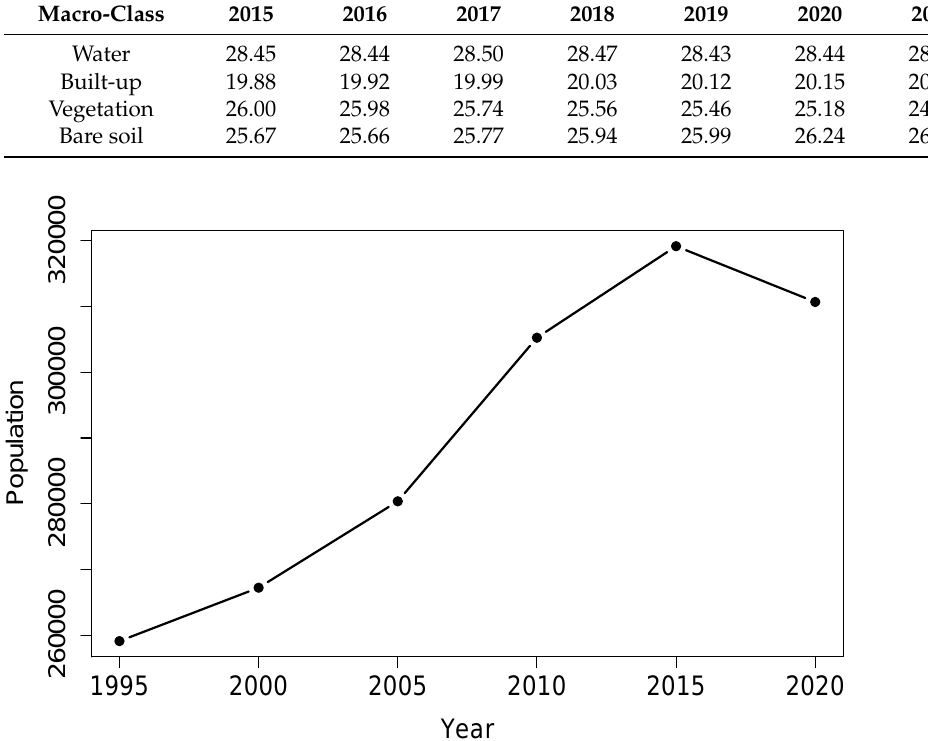
Figure 5. Last six five-year censuses in Coatzacoalcos, Veracruz. Source: National Institute of Statistics and Geography (INEGI)